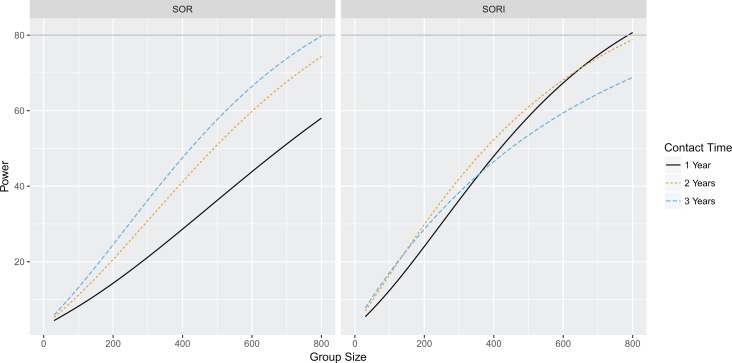
Power to estimate 25% total vaccine efficacy for SOR and SORI parameter estimates for contact times of one, two and three years Statistical power as a function of group size to estimate a significant difference in vaccinated and unvaccinated groups at the 95% level for an effect size of 25% total vaccine efficacy based upon SOR and SORI parameter estimates.Grey line indicates the 80% power level.